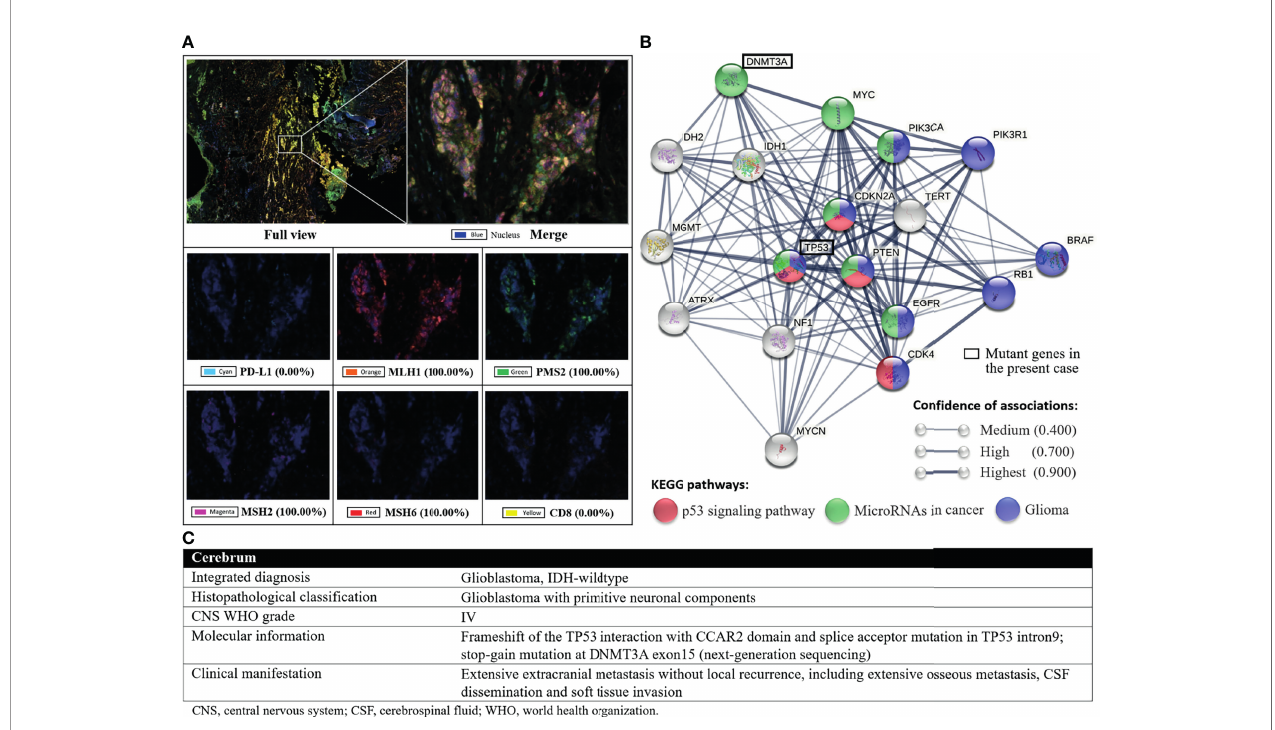
FIGURE 7 | (A) , the results of the multiplex immunohistochemistry with fl uorescence imaging. The positive rates of MLH1, PMS2, MSH2 and MSH6, the four main proteins involved in the DNA mismatch repair system, were 100%, indicating pro fi cient mismatch repair. (B) , the protein-protein interaction network computed by STRING v11.0 (URL: https://string-db.org/), which comprise two mutant genes in the present case and 16 frequently reported genes associated with GBM and GBM-PNC. The DNMT3A might play an important role in the epigenetic regulation of the biological behavior of GBM-PNC. (C) , the layered report of the con fi rmed diagnosis according to the 2021 WHO Classi fi cation of Tumors of the CNS (DOI: 10.1093/neuonc/noab106).